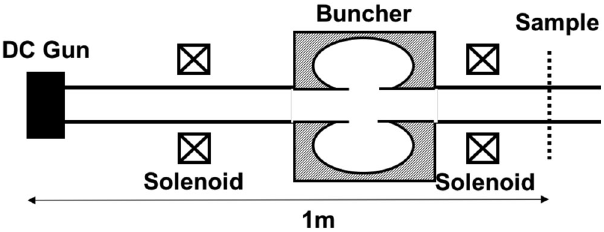
FIG. 2. Layout of the cryocooled dc gun UED beam line used in the following